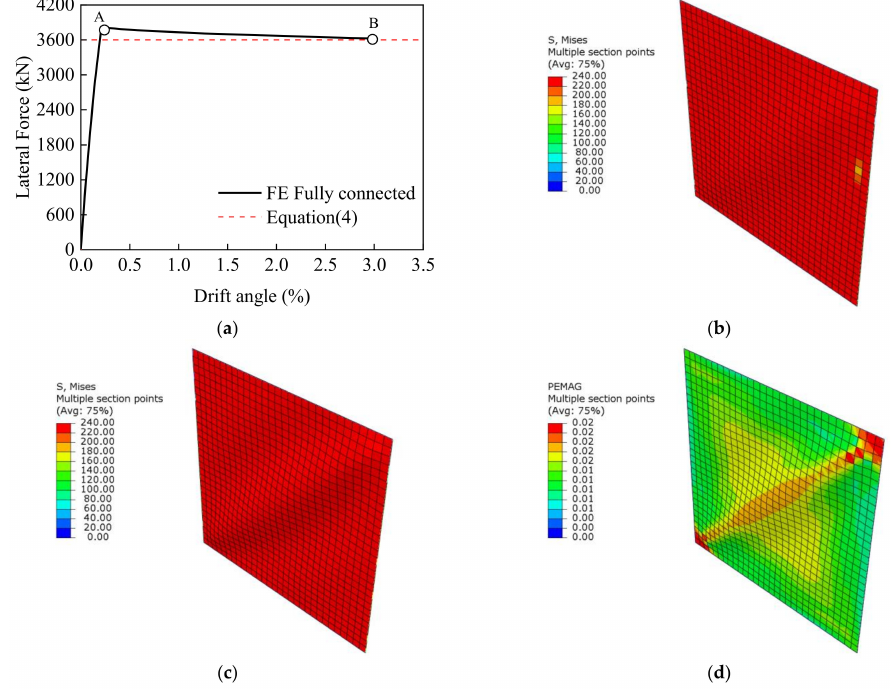
Figure 6. Load–displacement curve and stress of SPSW: ( a ) Load–displacement curve; ( b ) Stress distribution at point A; ( c ) Stress distribution at point B; ( d ) Plastic strain distribution at point